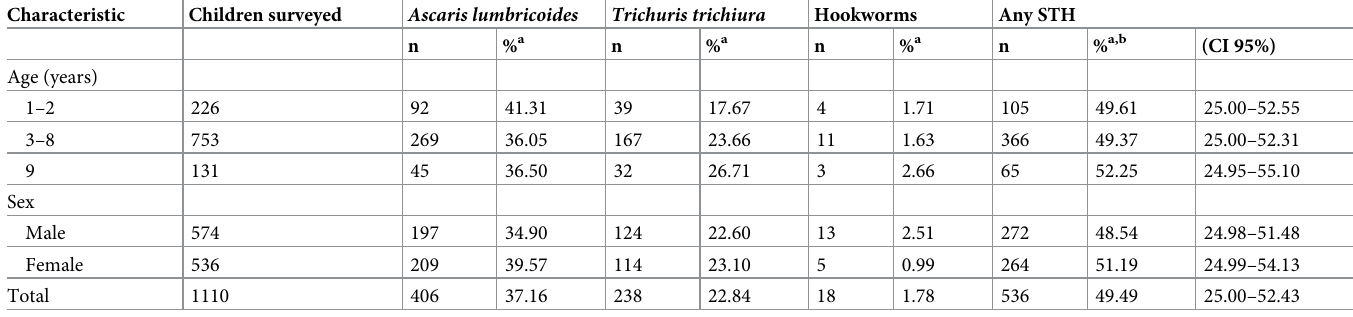
Table 3. Children surveyed and infected with soil-transmitted helminths according to demographic characteristics, rural communities of Loreto Department, Peru 2017. Characteristic